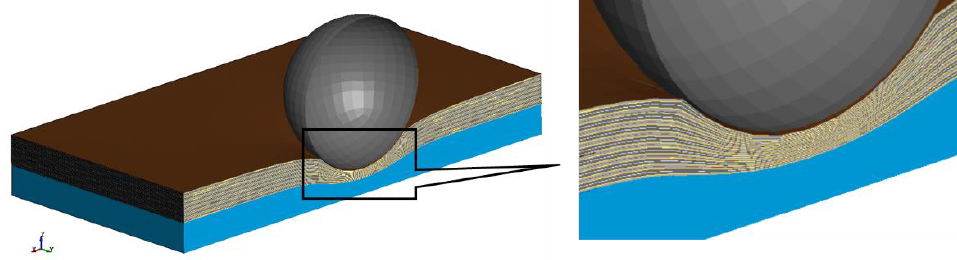
Figure 14. Simulation of a spherical indentation test for a battery cell with a hybrid modelling strategy. between the sphere and battery